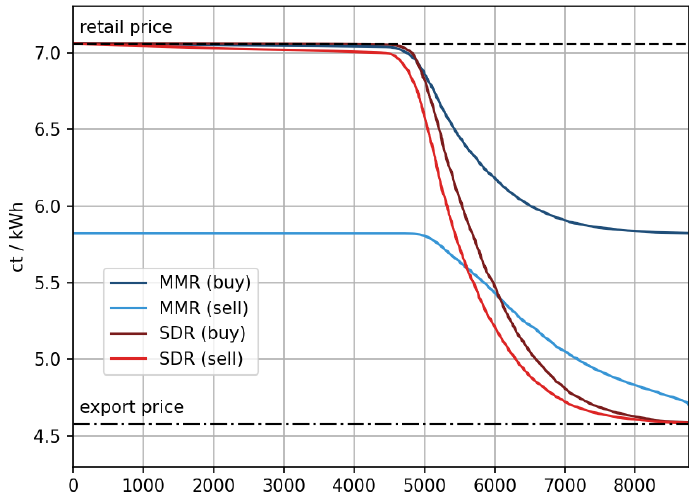
Figure 18. Price duration curve of average P2P prices (per hour) of all municipalities in the population ( n = 11,977).